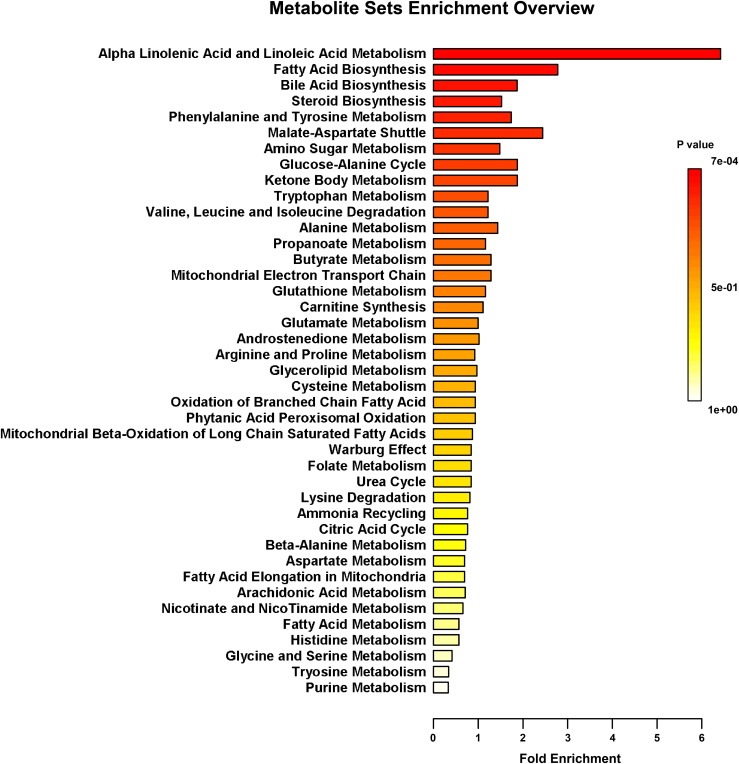
Metabolic pathway enrichment analysis. Overview of metabolites that were enriched in LBW piglets compared to the NBW ones. n = 6 per group.